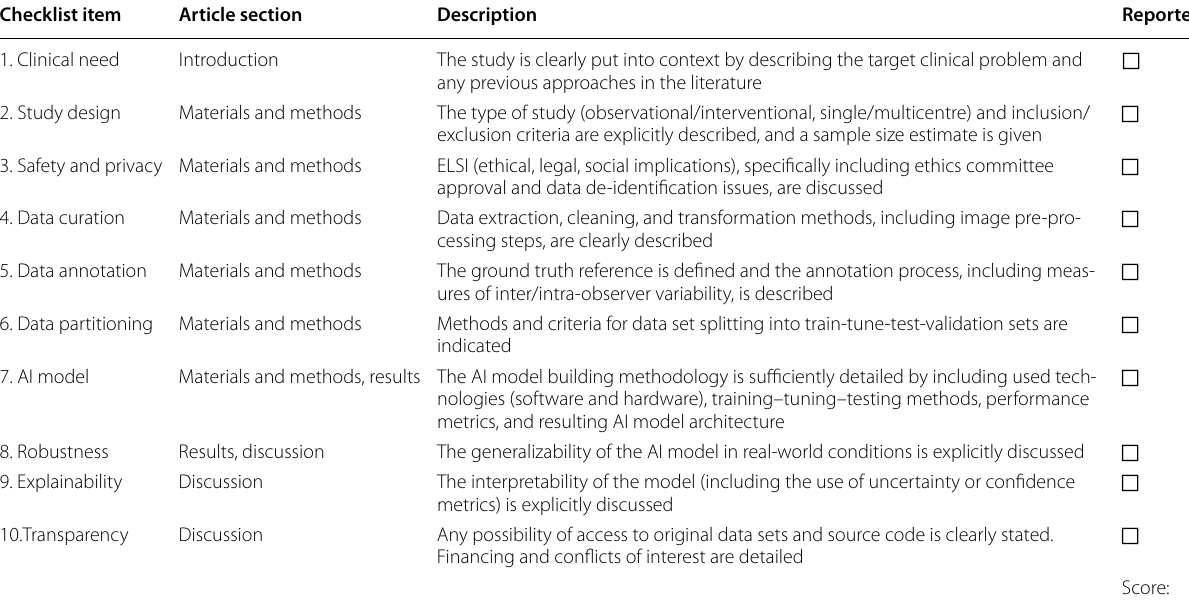
All the listed sub‑items under the descriptions should be addressed to consider that the corresponding item has been fulfilled. The MAIC‑10 checklist is structured based on the different sections of a research publication: Introduction, Materials and Methods, Results and